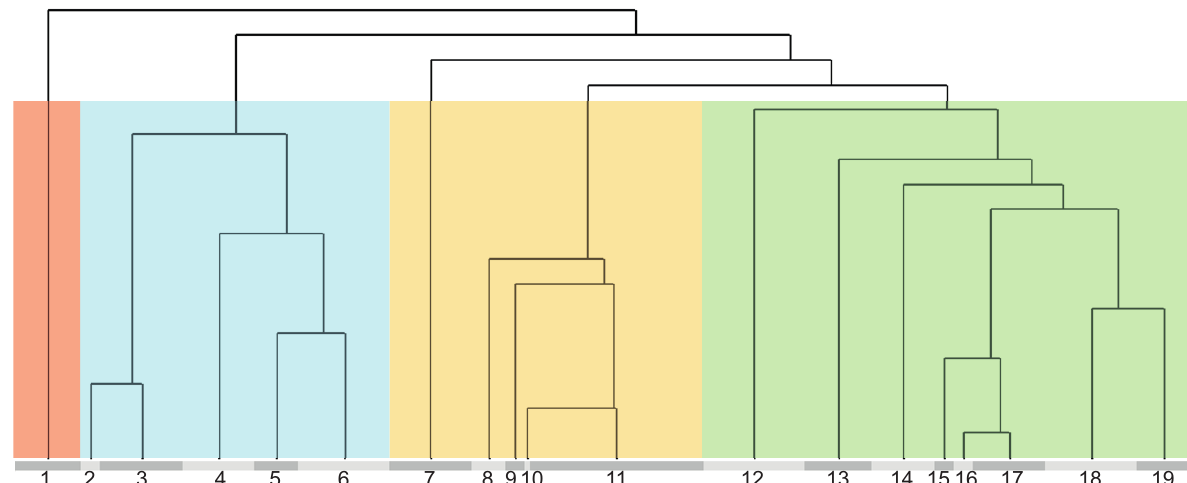
Figure 2. Dendrogram illustrating the assigment of relevé groups identified by TWINSPAN to particular syntaxo- nomic units (see Syntaxonomic synopsis). The different background colors refer to alliances: red – Poion alpinae , blue – Ligulario thomsonii-Geranion regelii , orange – Rheion maximowiczii and green – Scabioso songaricae-Phlomoidion lehmannianae .